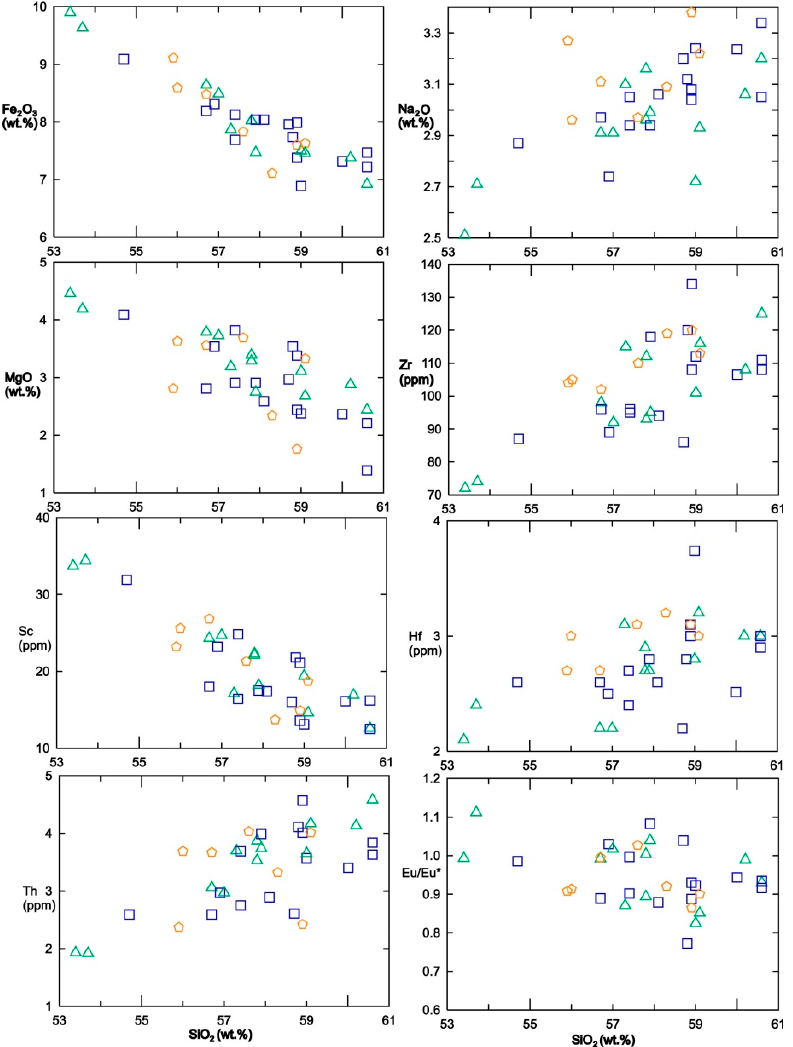
Figure 10. Major and trace elements Harker-type variation diagrams for the Bont ă u volcanic complex. Symbols and source of the data as in Figure 9. The CI-chondrite normalized rare-earth element (REE) and primitive mantle patterns [49] show small differences between sample compositions with faintly exception of Nb and Ta that show a lesser trough and higher HREE for the dome rocks (Figure 11) similar with the Group 1-Z rocks.